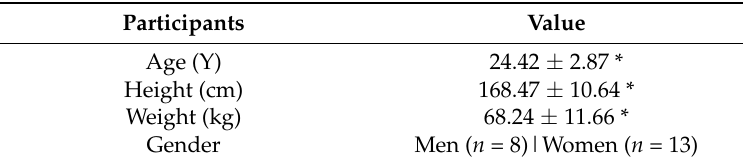
Table 1. Participant’s characteristics